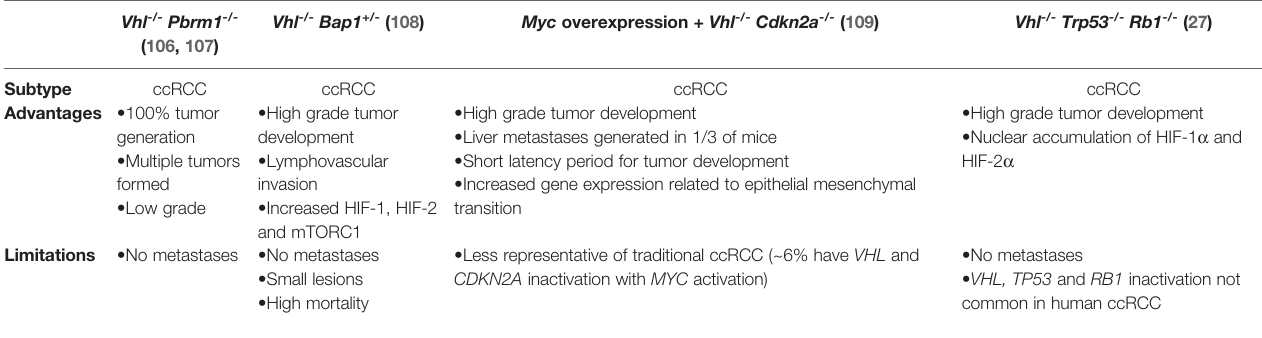
TABLE 2 | Genetically engineered mouse models used for kidney cancer research.